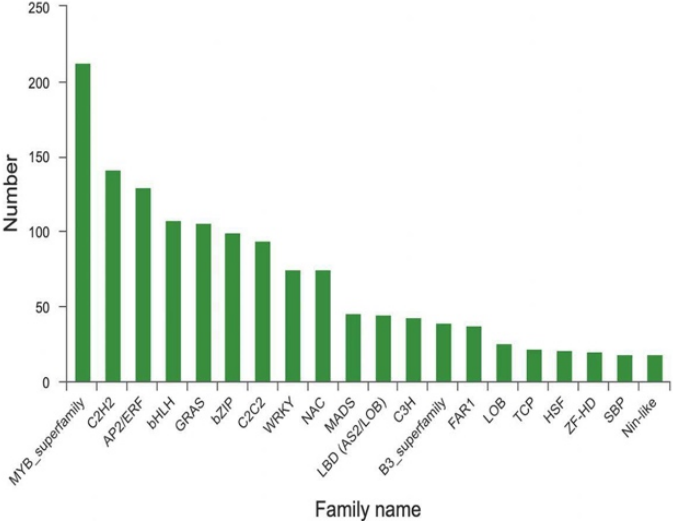
Figure 11. Transcription factors involved in FA biosynthesis. TFs were compared with PlantTFDB 4.0; MYB , C2H2 , AP2/ERF , bHLH , GRAS , bZIP , C2C2 , and WRKY were screened as the main TFs